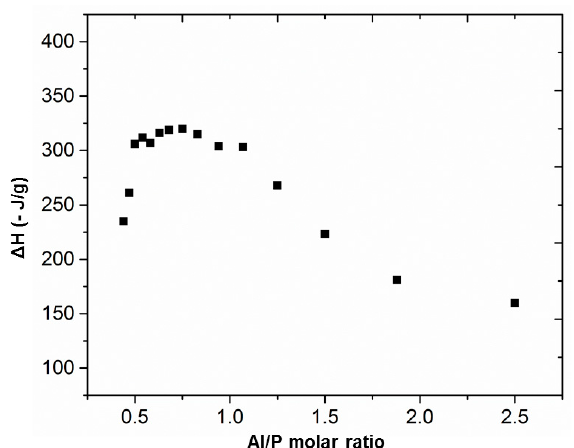
Figure 2. Evolution of the reaction enthalpy as a function of Al/P molar ratio, by means of isothermal calorimetry, 60 °C.